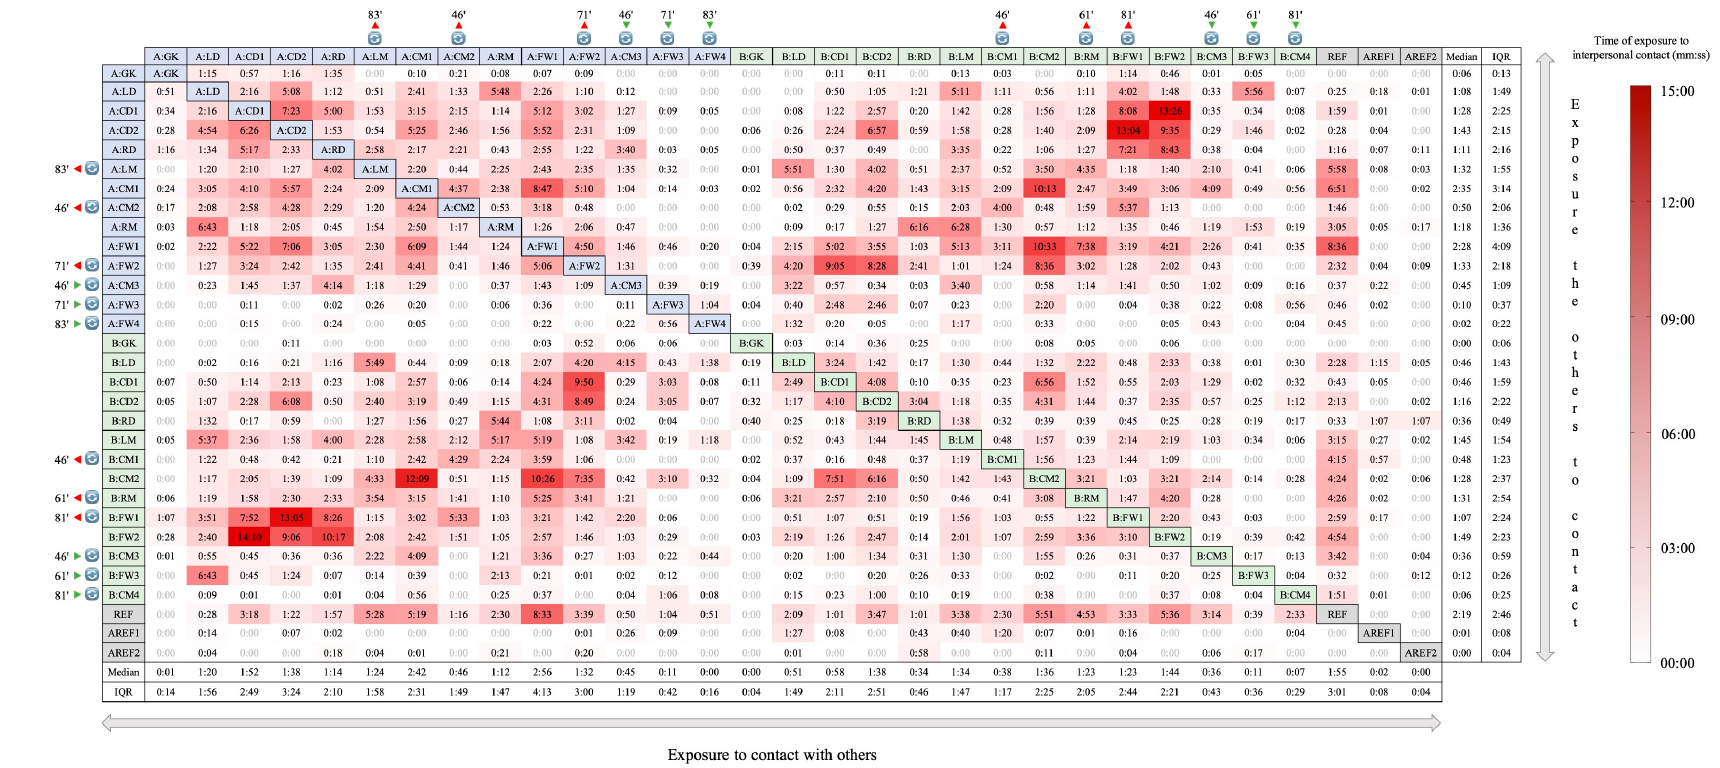
Figure 4. Accumulated weighted-time (mm:ss) each individual was exposed for less than 2 m to other individuals (players and referees) and their tracks of respiratory droplets left by their movements. Blue cells represent players from team A, green from team B, and grey the referees. The symbol depicts the players that were substituted and the match time of occurrence. The figure allows double information and should be read according to rows and columns: rows show the exposure to contact with other individuals (e.g., A:GK was exposed during 1:15 mm:ss to A:LD, 0:57 mm:ss to A:CD1, etc.; columns show the time that each individual exposed the others to contact with himself (e.g., A:GK exposed A:LD to 0:51 mm:ss, A:CD1 to 0:34 mm:ss, etc.). The last rows and columns show the corresponding median and interquartile range (IQR). Darker shades indicate a higher time of exposure to interpersonal contact. GK = Goalkeeper, LD = Left Defender, CD = Central Defender, RD = Right Defender, LM = Left Midfielder, CM = Central Midfielder, RM = Right Midfielder, FW = Forward, REF = Referee, AREF = Assistant Referee.